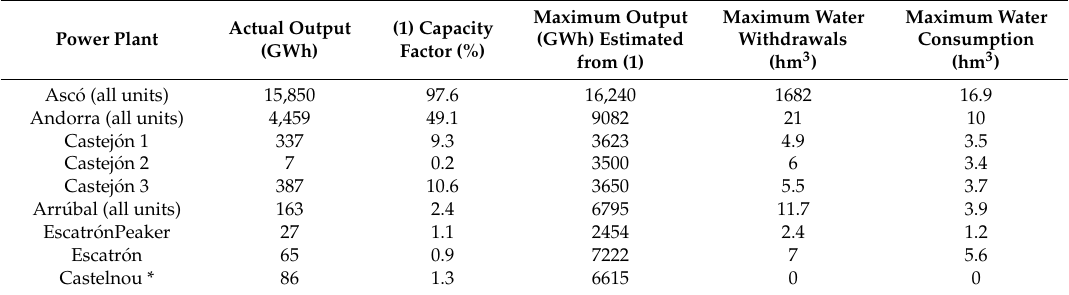
Table 4. Estimation of the maximum output, water withdrawals and water consumption attainable by the thermal power plants of the Ebro River